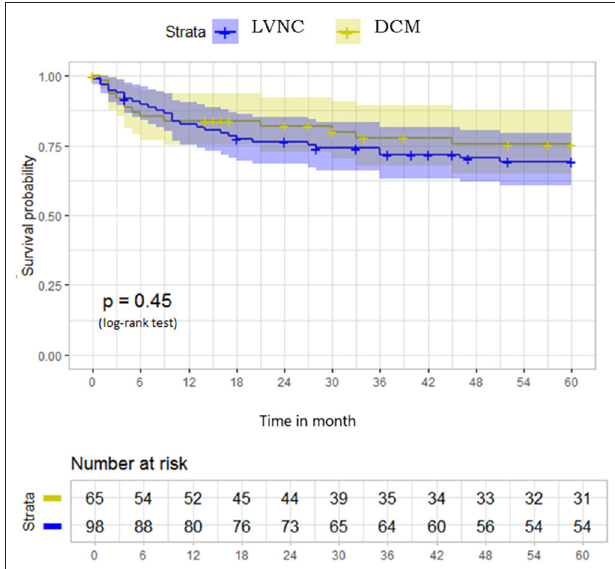
FIGURE 2 | Survival free from primary outcome at 5-year follow-up in the whole population of 98 LVNC and 65 DCM cases. LVNC, left ventricular non-compaction; DCM, dilated cardiomyopathy.